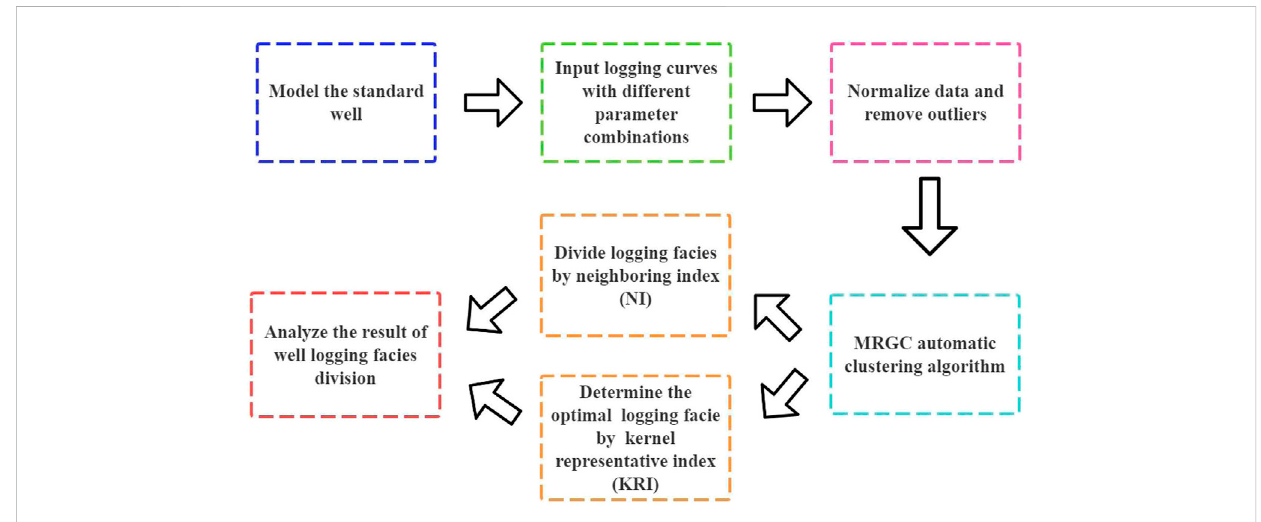
FIGURE 7 Flow chart of the MRGC algorithm logging facies